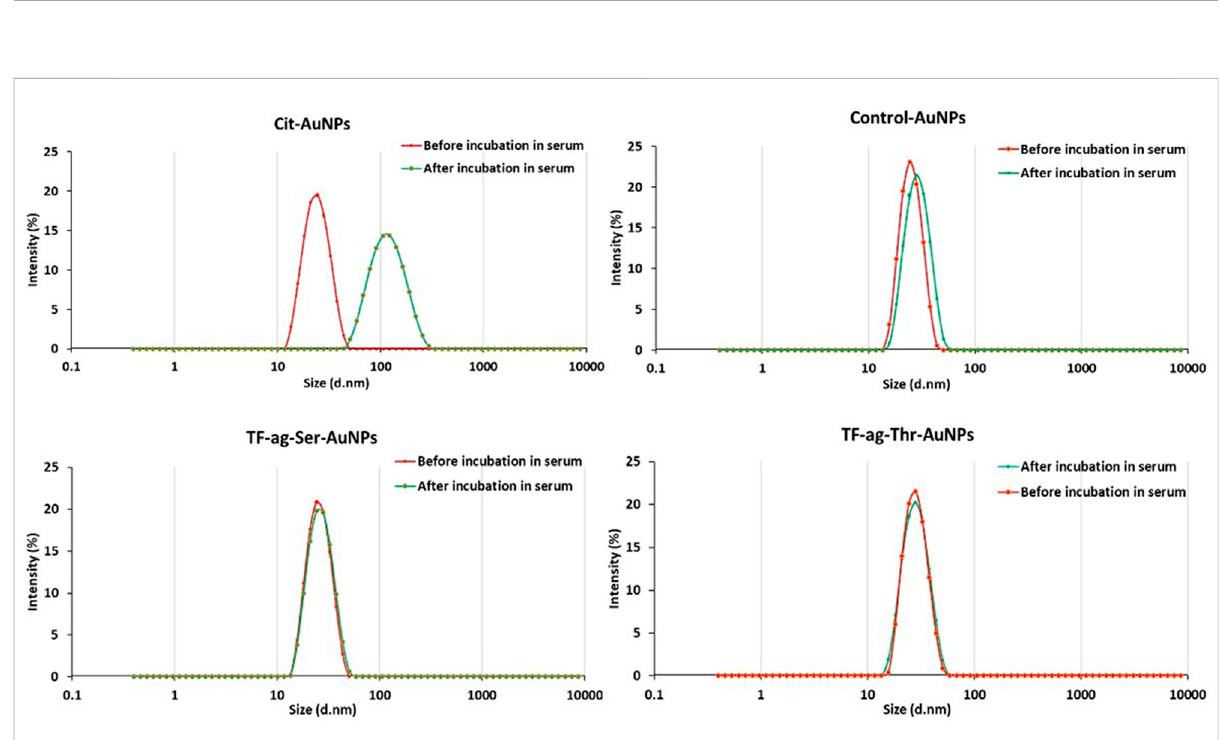
FIGURE 4 Stability in human serum as analyzed by Dynamic Light